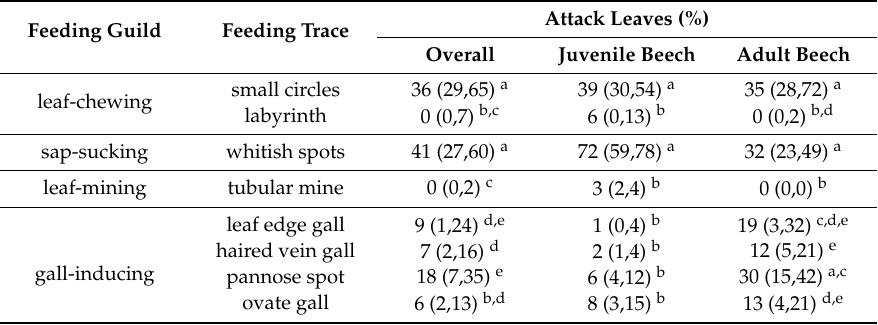
post-hoc test ( p ≤ 0.05; df =